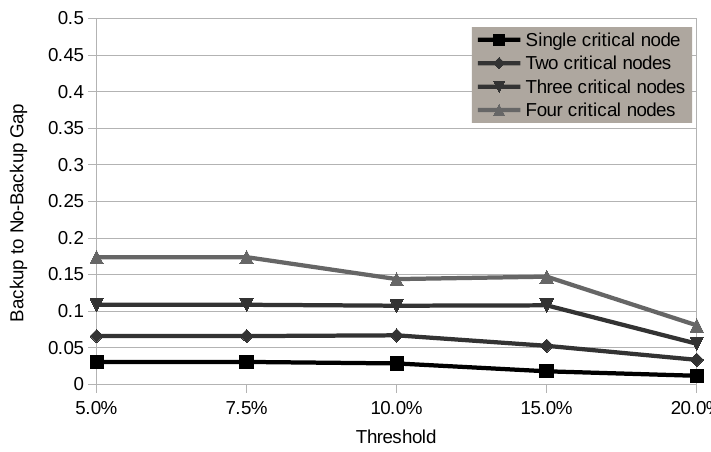
Figure 10. Increase on distance values, obtained by the heuristic, when backup is provided.